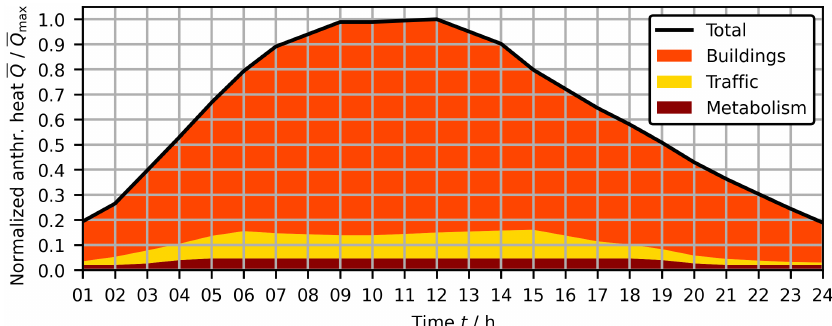
Figure 3. Mean normalized anthropogenic heat profile calculated by the LUCY model. The total value as well as the contributions of buildings, traffic and human metabolism are